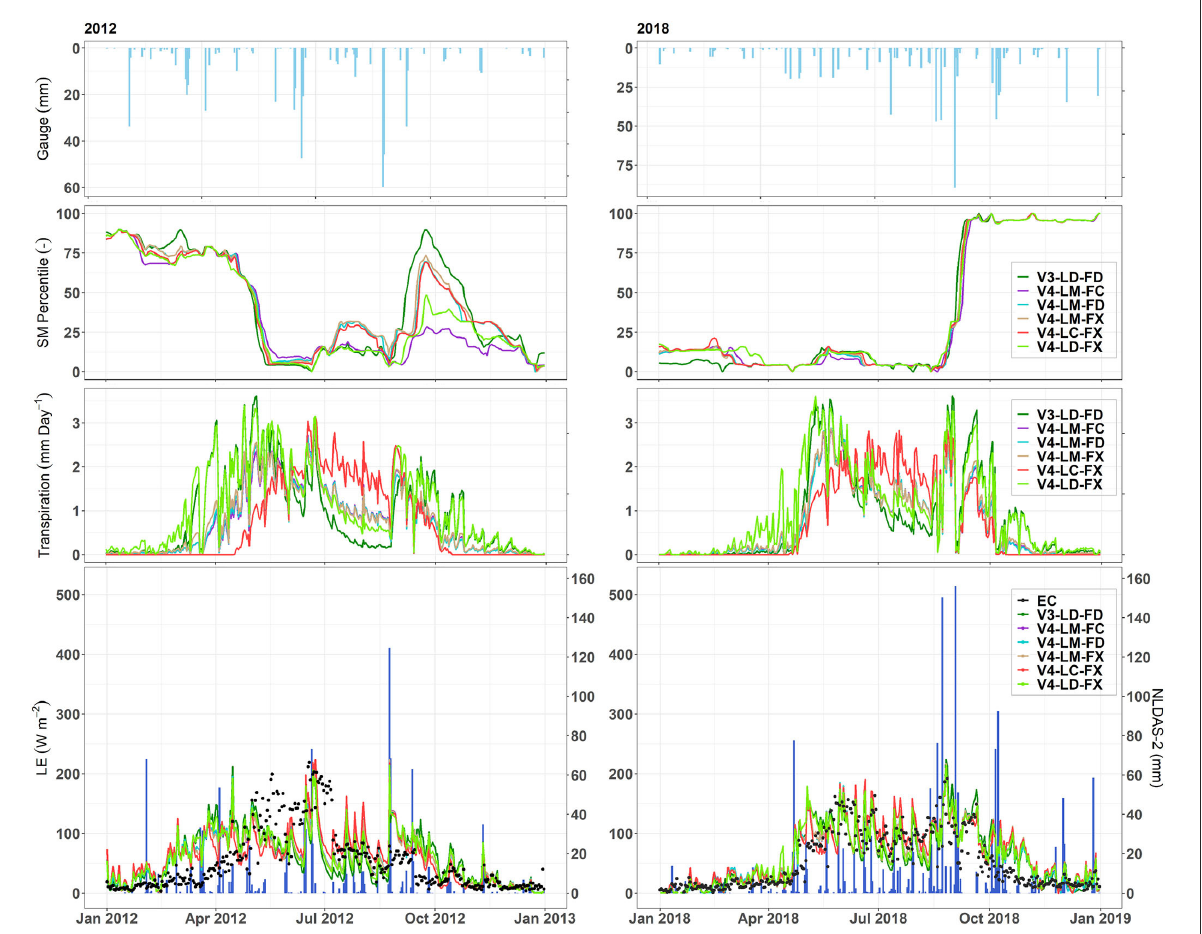
FIGURE5 Precipitation, top 1-m soil moisture percentile, transpiration, and LE at the KON site for two selected drought years (2012, left; and 2018, right). (Top panels) Gauge precipitation measurements at the site; (Second row) top 1-m soil moisture percentile; (Third row) Transpiration; (Bottom panels) Comparison of average daily simulated LE from all different Noah MP configurations (various colored lines) vs. EC measurements (black dots) and NLDAS-2 precipitation forcing (blue